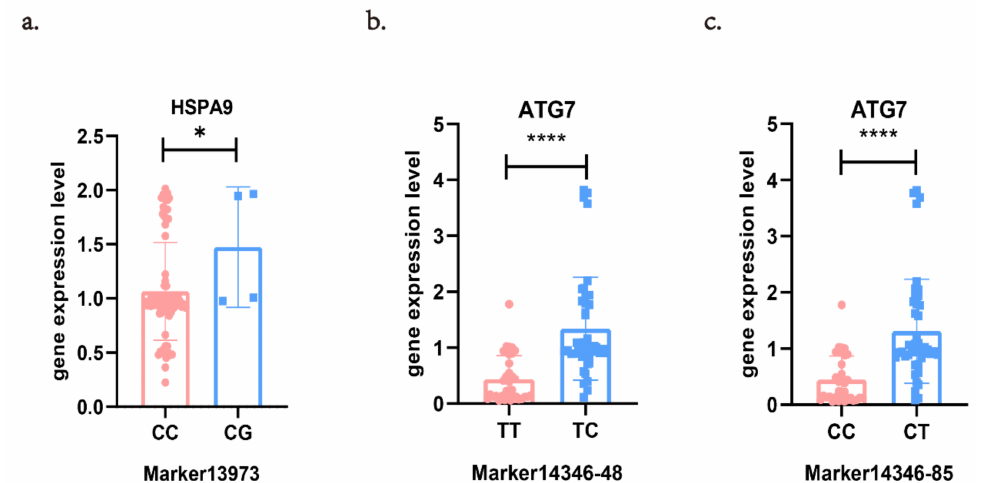
Figure 1. Association between different genotypes of single nucleotide polymorphisms (SNPs) and the gene expression level. ( a ) HSPA9 gene expression level with different genotypes of Marker13973. ( b ) ATG7 gene expression level with different genotypes of Marker14346-48. ( c ) ATG7 gene expression level with different genotypes of Marker14346-85. The error bars denote the standard error of the mean. Asterisks indicate significant differences between different genotypes of SNPs. * indicates p < 0.05. **** indicates p <